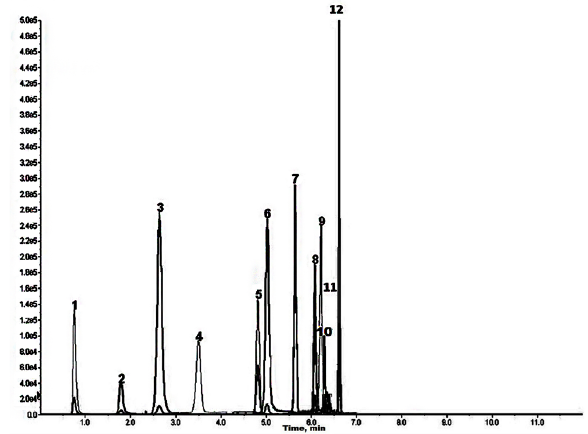
Figure 1: Exemplary LC-ESI-MS/MS chromatogram of analyzed phenolic acids. For compound numbers see Table 1. See Experimental section for details.